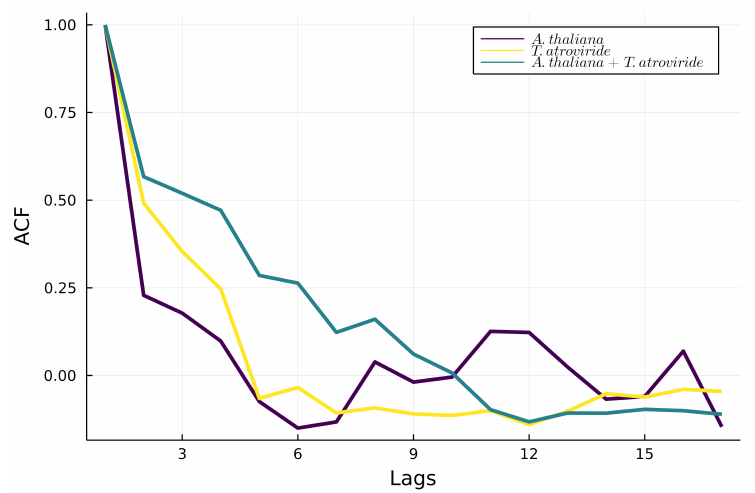
Figure 6. Autocorrelation of the 6-PP signal for the individual organisms: Arabidopsis thaliana (purple line), Trichoderma atroviride (yellow line), and (C) A. thaliana + T. atroviride interaction (green line).